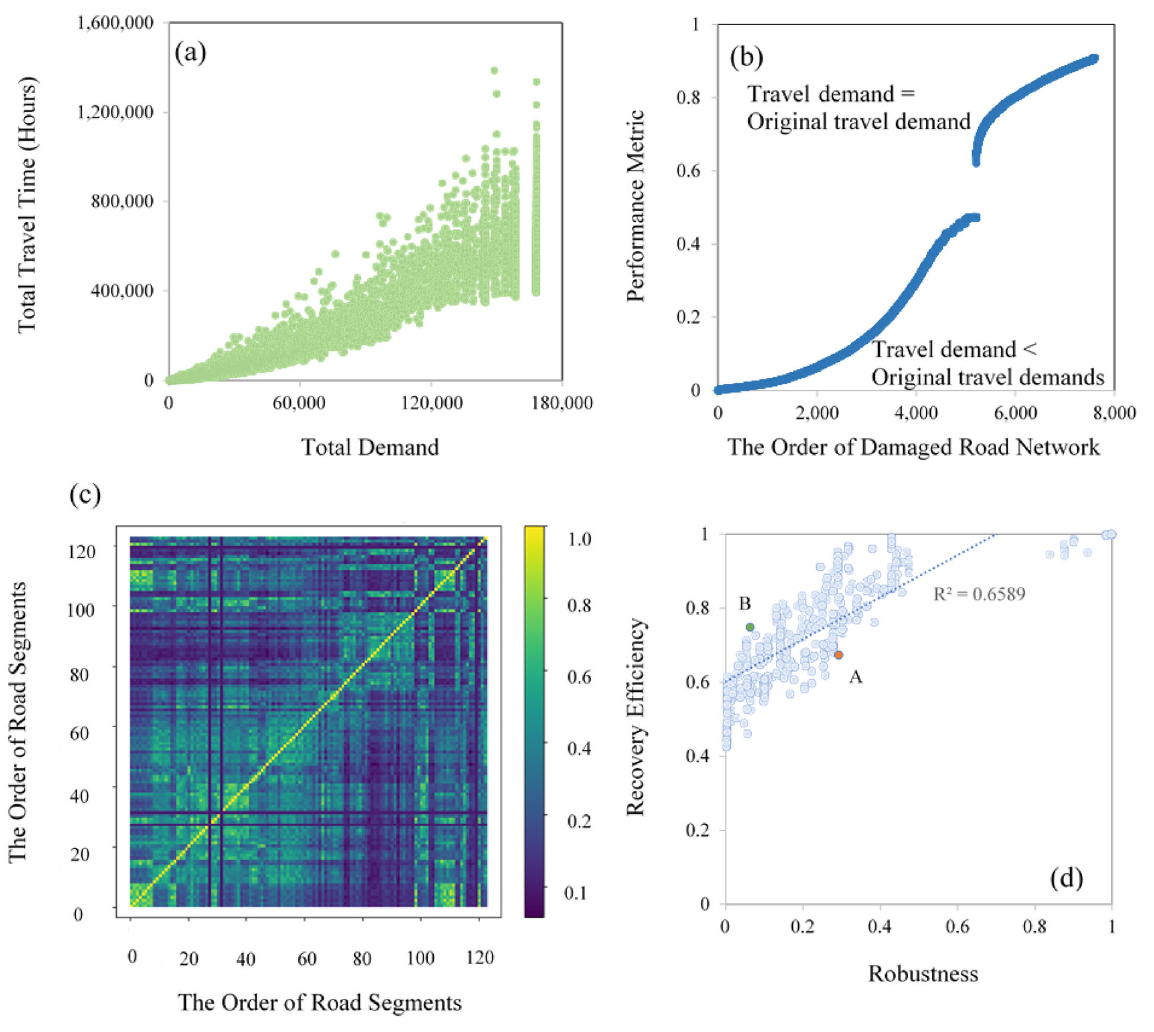
Fig. 6 Simulation result analysis. a Relationship between travel time (unit: hours) and satisfied travel demand. b Performance values of all damaged road network in descending order. c Correlation of status of road segments. d Relationship between robustness and recovery